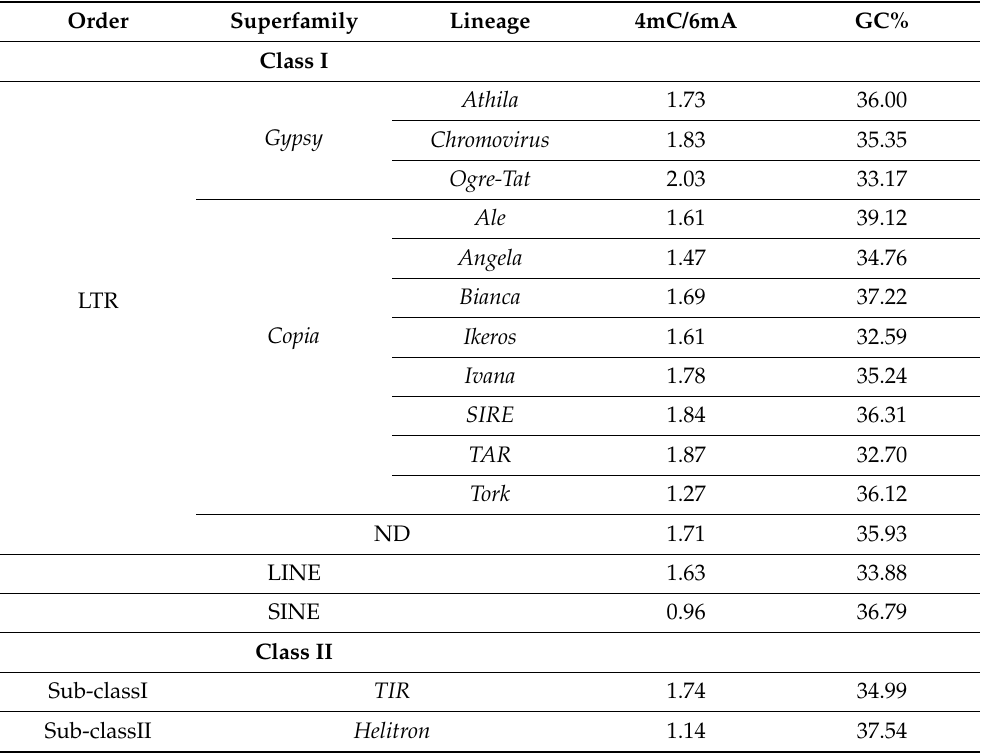
Table 1. Ratio of 4mC and 6mA modification and GC content % in the different types of repeats of